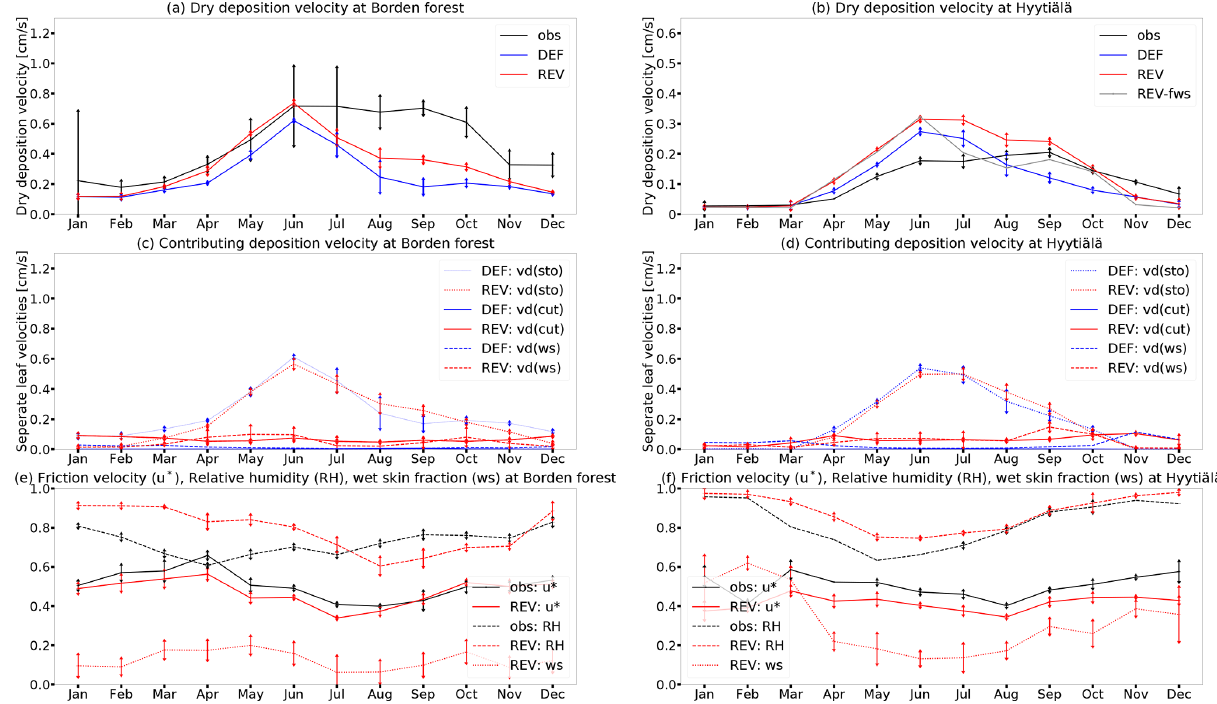
Figure 3. Measured (obs) and modelled (DEF, REV) multiyear mean (2010–2012) and REV-fws (2010) annual cycle. (a, c, e) Borden forest and (b, d, f) Hyytiälä; arrows indicate 1 σ